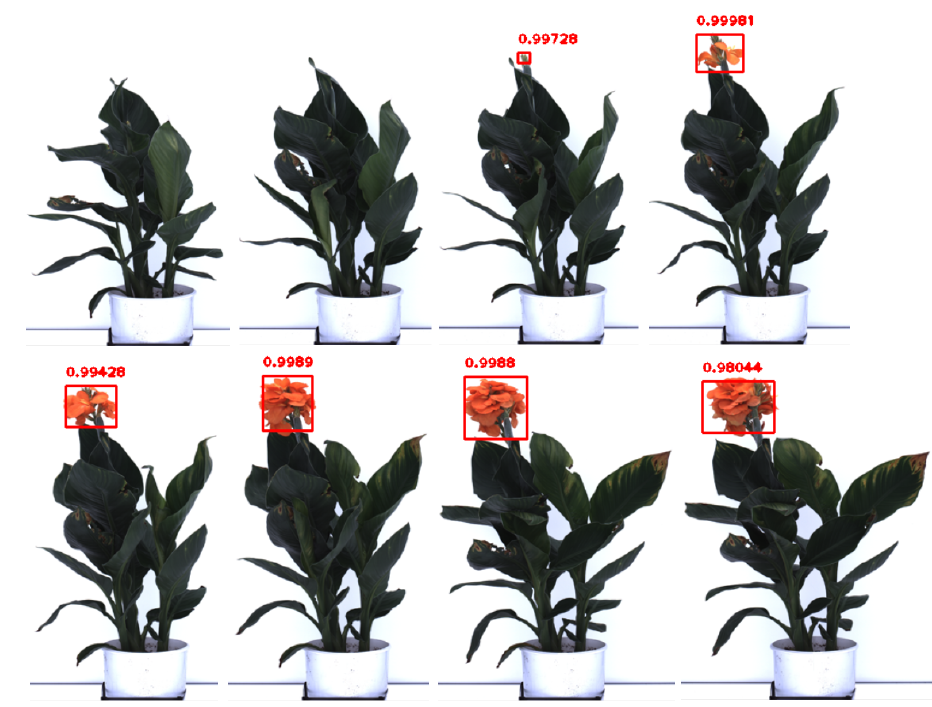
Figure 12. Illustration of flower emergence timing detection and its growth over consecutive days (following left to right direction) using a sample canna image sequence (D1) for the side view 0 ◦ starting from Day 28 ( top-left ) to Day 35 ( bottom-right ).